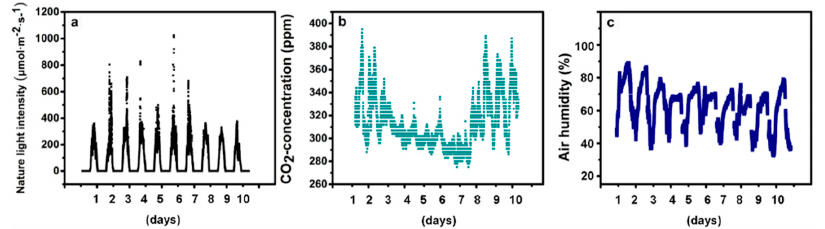
Figure 8. Environmental conditions of the greenhouse. The details of ( a ) the nature light intensity, ( b ) the CO 2 concentration, and ( c ) the air humidity of the greenhouse.